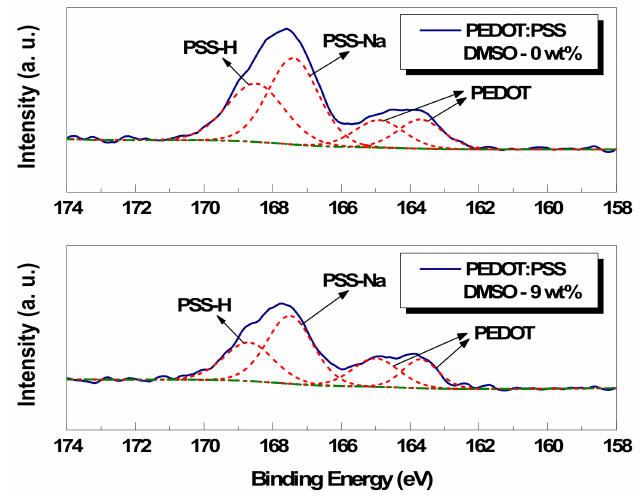
Figure 7. S(2p) core-level spectra of pristine and 9 wt% DMSO paste film.